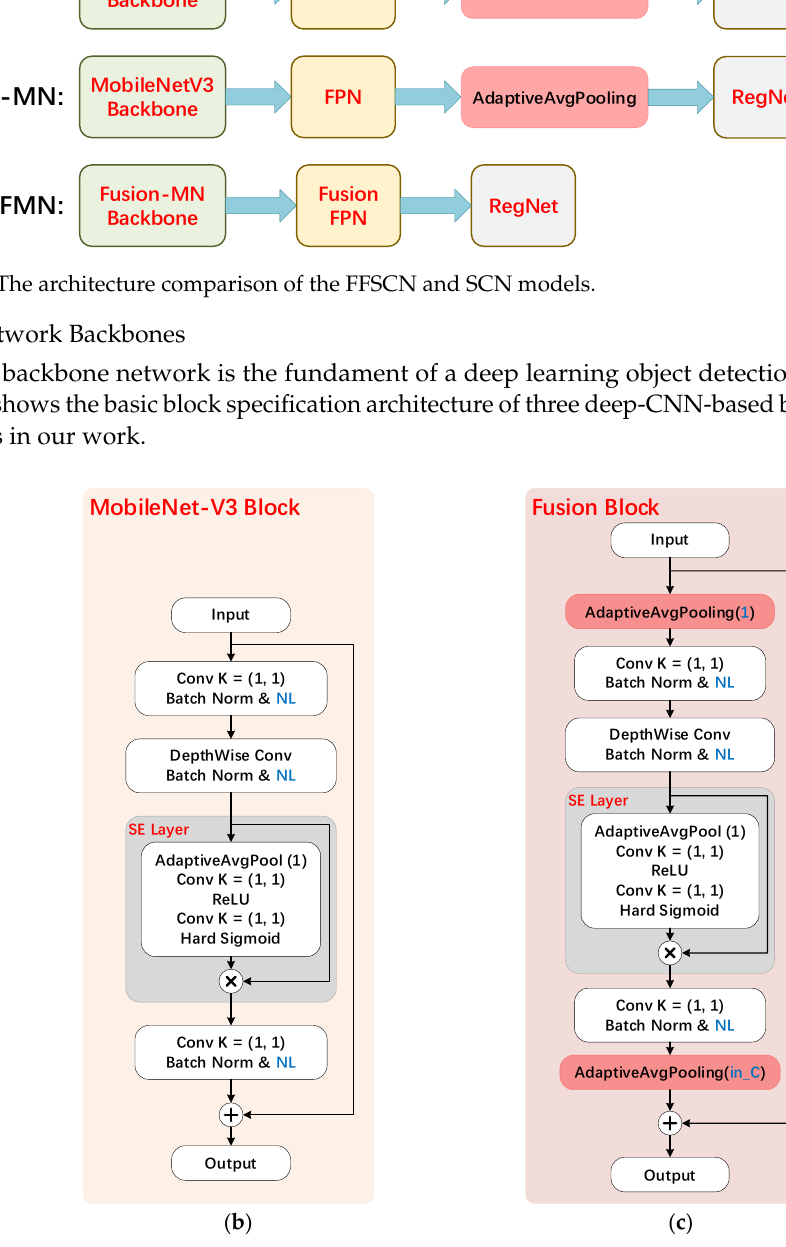
Figure 2. The basic block structure of the deep-CNN-based backbone network. ( a ) The Residual block. ( b ) The MobileNetV3 block. ( c ) The proposed Fusion block, consistent with the MobileNetV3 block, uses a different nonlinear (NL) activation depending on the layer, and in_C denotes the input channels.